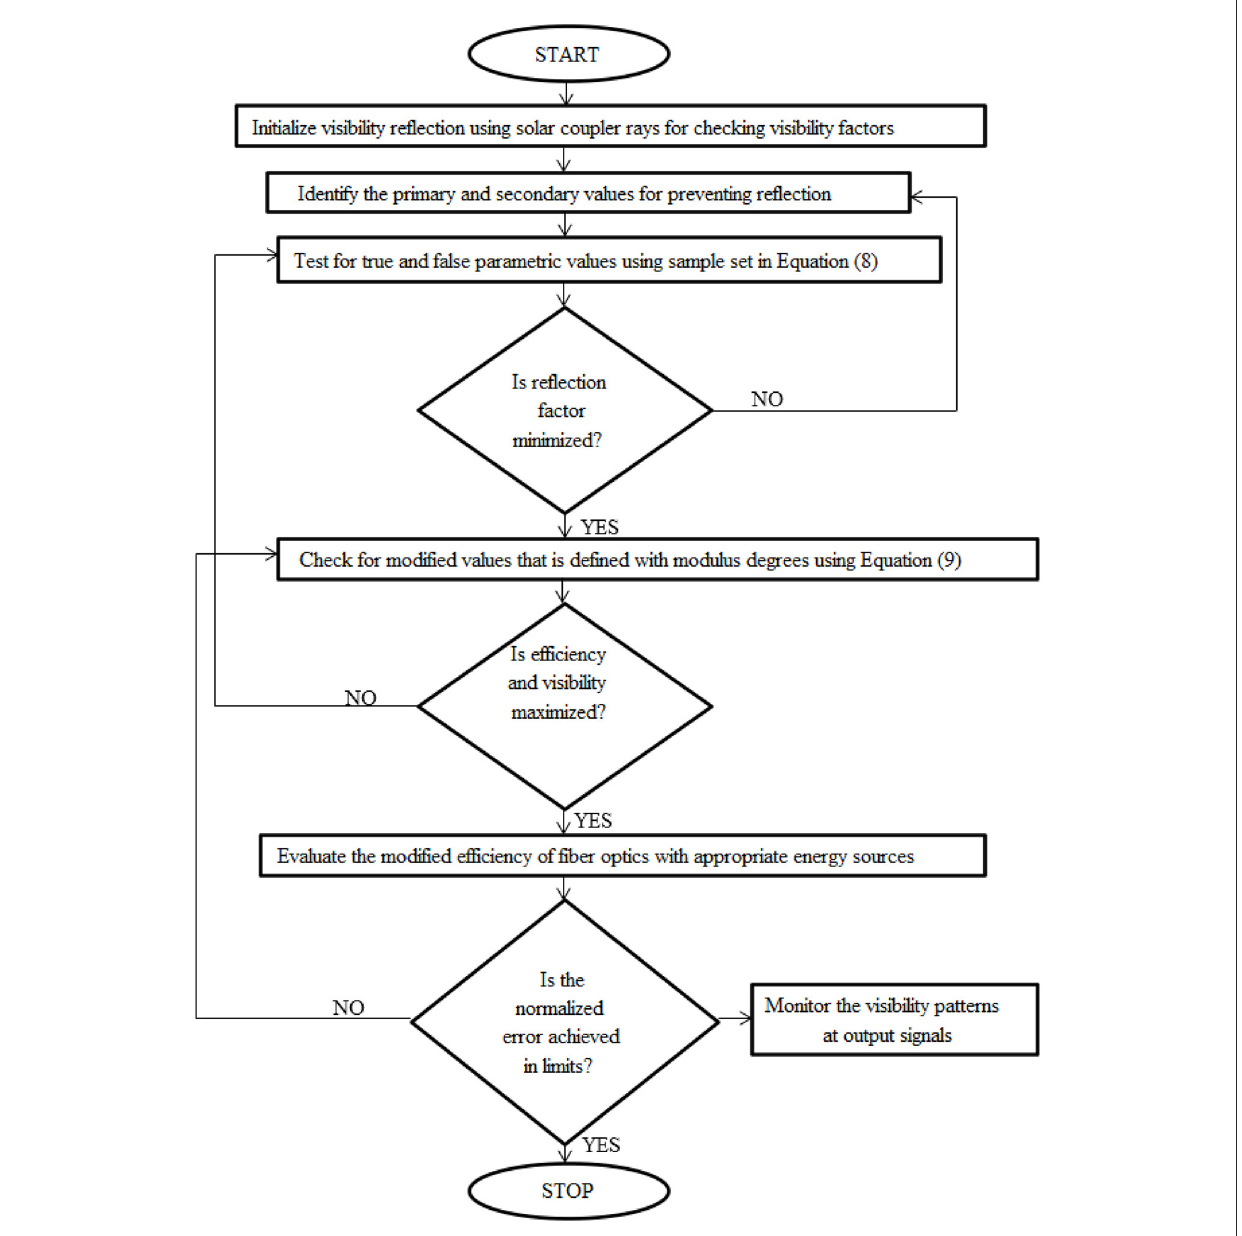
FIGURE1 General adversarial network for fiber optics.